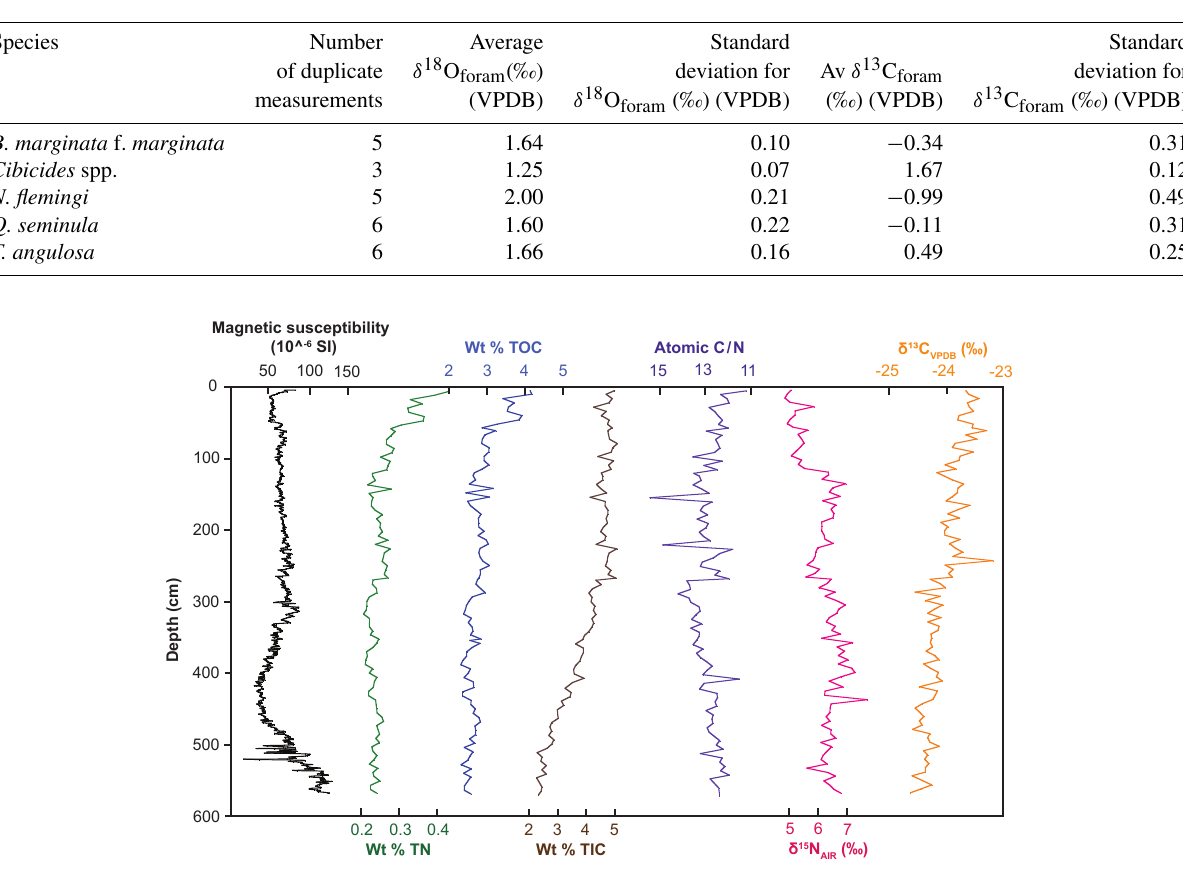
Figure 6. Downcore sedimentary parameters plotted against depth for core 36P4 collected in Hanfield Inlet: magnetic susceptibility, wt% nitrogen (TN), wt% organic carbon (TOC), wt% carbonate (TIC), δ 13 C, δ 15 N, and atomic C / N of bulk sediment (note reversed scale). See text for error on replicate